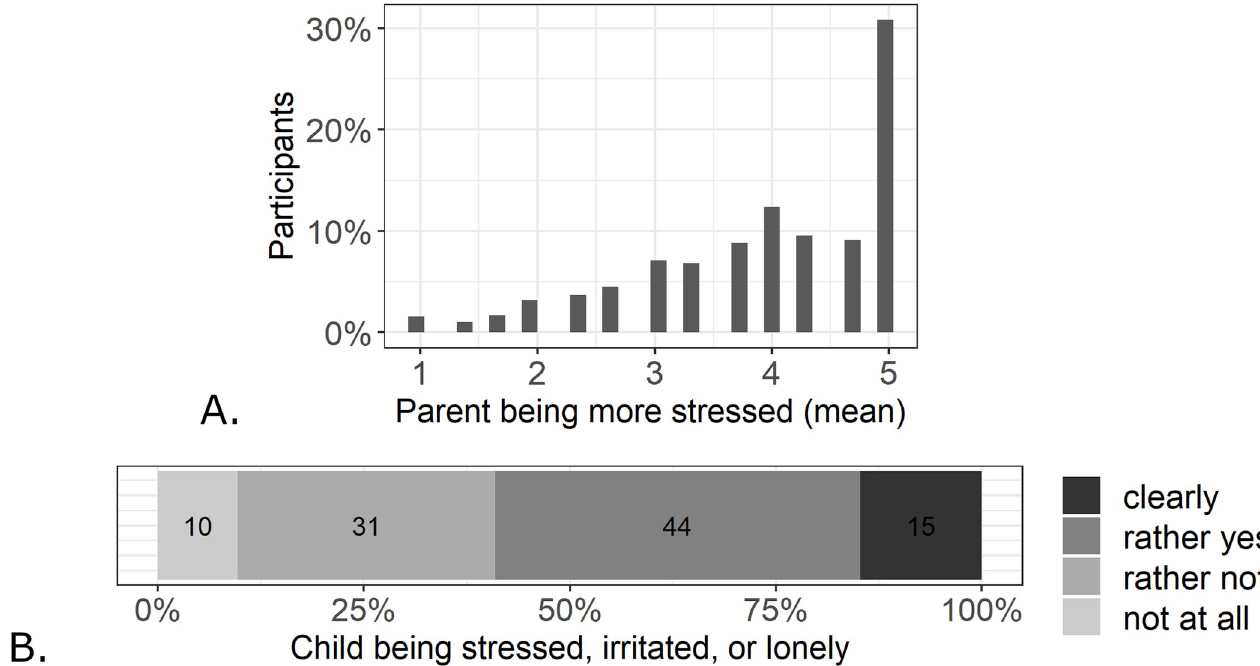
Fig 1. A: Percentage of parents’ mean ratings on items regarding current stress. B: Percentage of children who are reported to be stressed, irritated, or lonely with regard to the current situation.